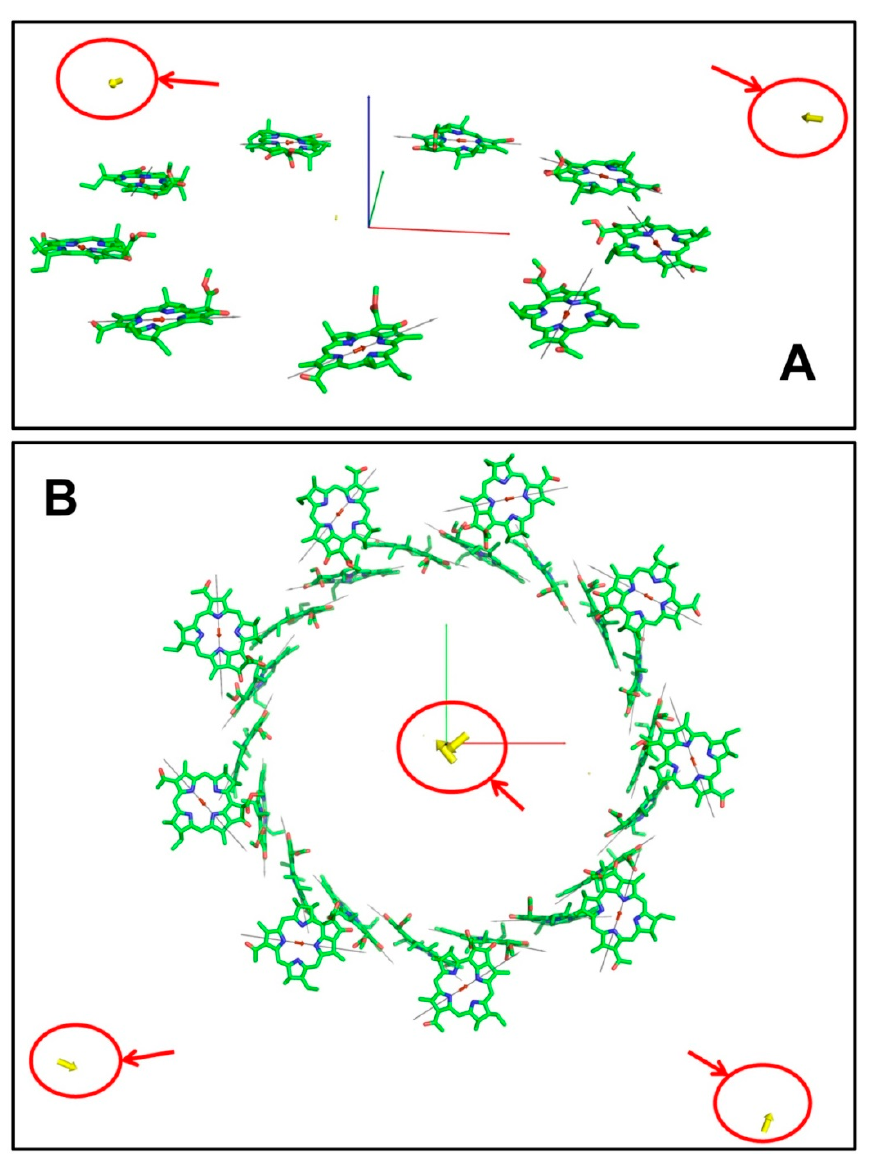
Figure 5. Visualization of the exciton Q y transition moments D µ (yellow arrows) for the B800 ring ( A ) and for the whole LH2 complex ( B ). Gray thin arrows are the NB–ND directions in BChl; small red arrows in the middle of pyrrole rings are the Q y transitions in the coordinate representation. Red circles mark the locations of the transition moments for the two most intensive exciton states in the B800 ring and in LH2.